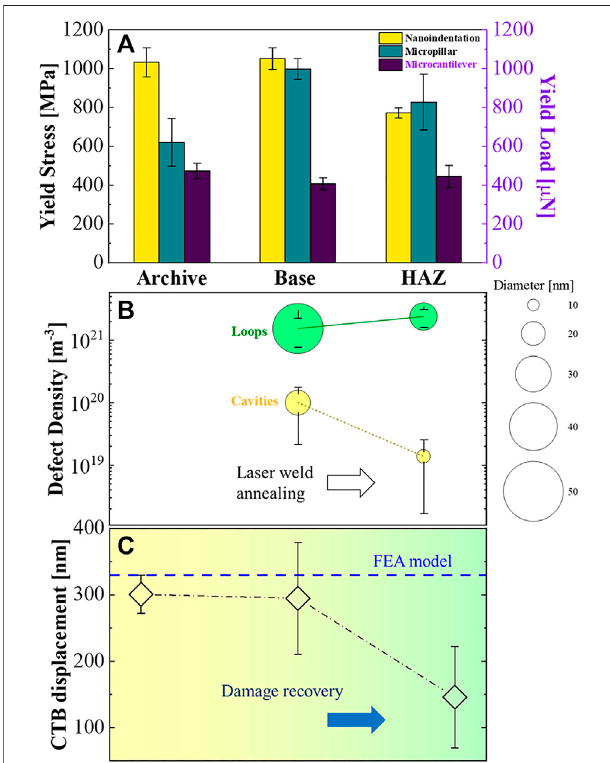
FIGURE 6 | Microstructure-mechanical property relationships across the irradiated base metal and HAZ with respect to the archive control specimen (Mao, 2019; Mao et al., 2019; Mao et al., 2020b). (A) Yield stress measured by nanoindentation and micropillar compression experiments. (B) Comparison of size and number density of dislocation loops and cavities in the base metal and HAZ. (C) Comparison of experimentally measured and FEA predicted crack tip blunting